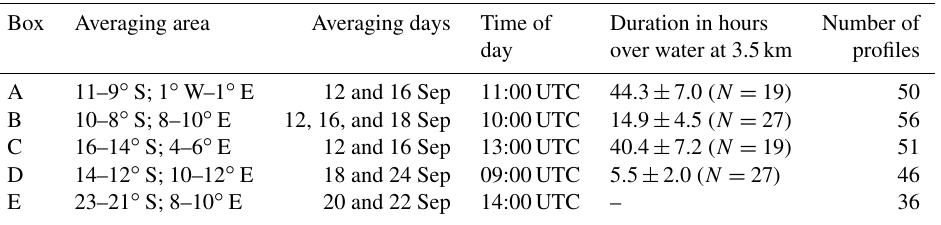
Figure 1. MERRA2 monthly mean reanalysis of 900 and 650hPa streamlines for September 2016. Stations marked are Ascension Island (ASI), Lubango (LUB), a long-term AERONET site at 2km elevation, and Walvis Bay (WB) where ER-2 flights originated from during the September 2016 ORACLES IOP. Flights in August 2017 and September/October 2018 originated from São Tomé (ST). Table 1. Averaging area, flight time periods, the duration over water and number of HYSPLIT backward trajectories, and number of HSRL-2 profiles in each grid box used in the